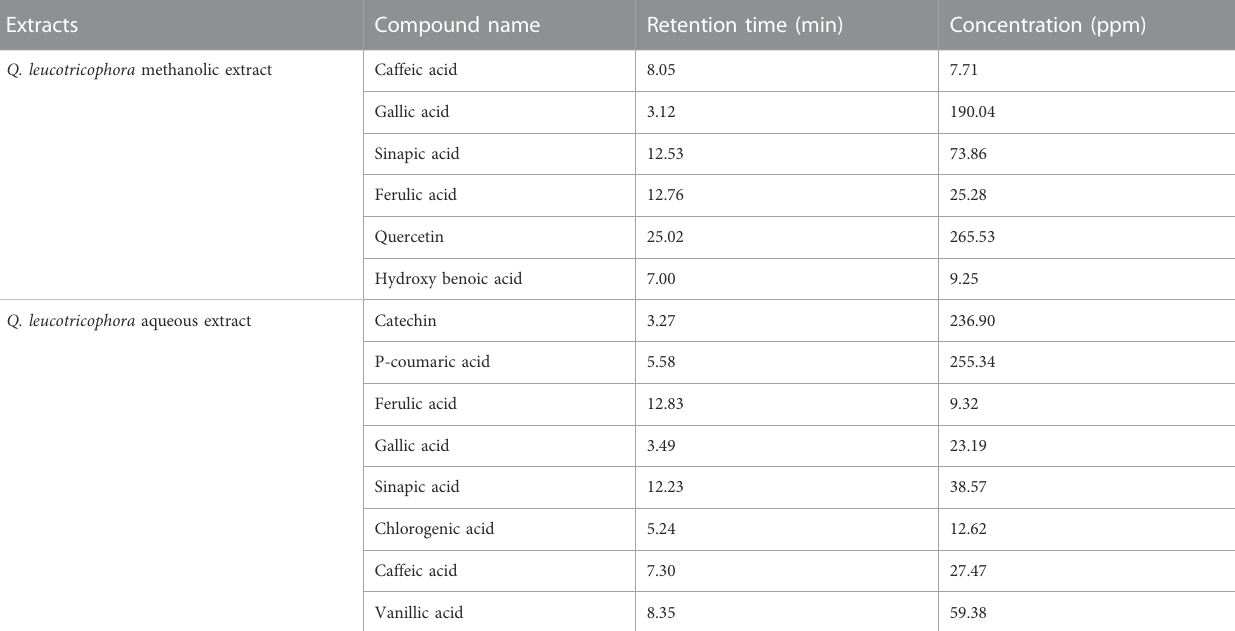
TABLE 1 HPLC pro fi le of phytochemicals detected in methanolic and aqueous extracts of Quercus leucotrichophora .